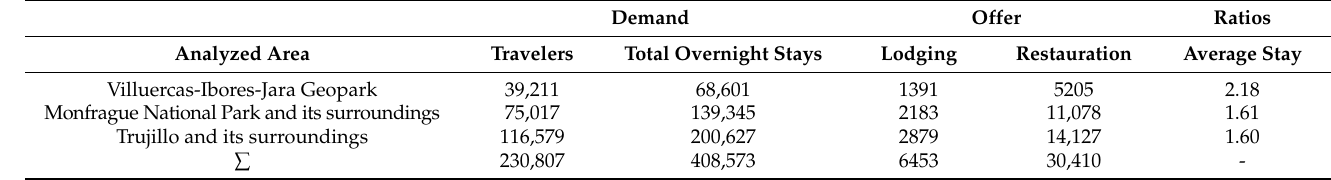
Table 1. Tourism parameters of the analyzed areas (2019).